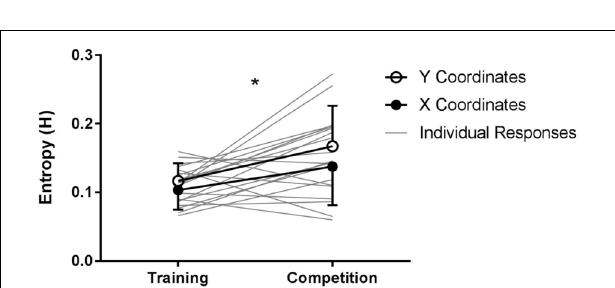
FIGURE 2 | Rating scale of mental effort results for training and competition fights. Mean results and standard deviations are presented in bold, individual results are presented in light gray. ∗ Indicates a significant difference between conditions ( p < 0.05).